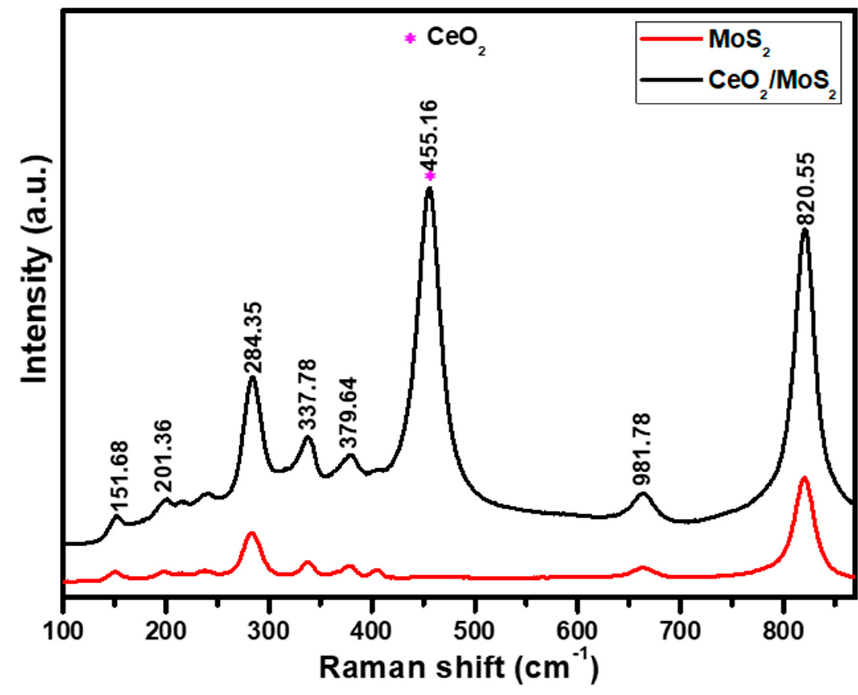
Figure 2. Raman spectra of MoS 2 and CeO 2 /MoS 2 composite.